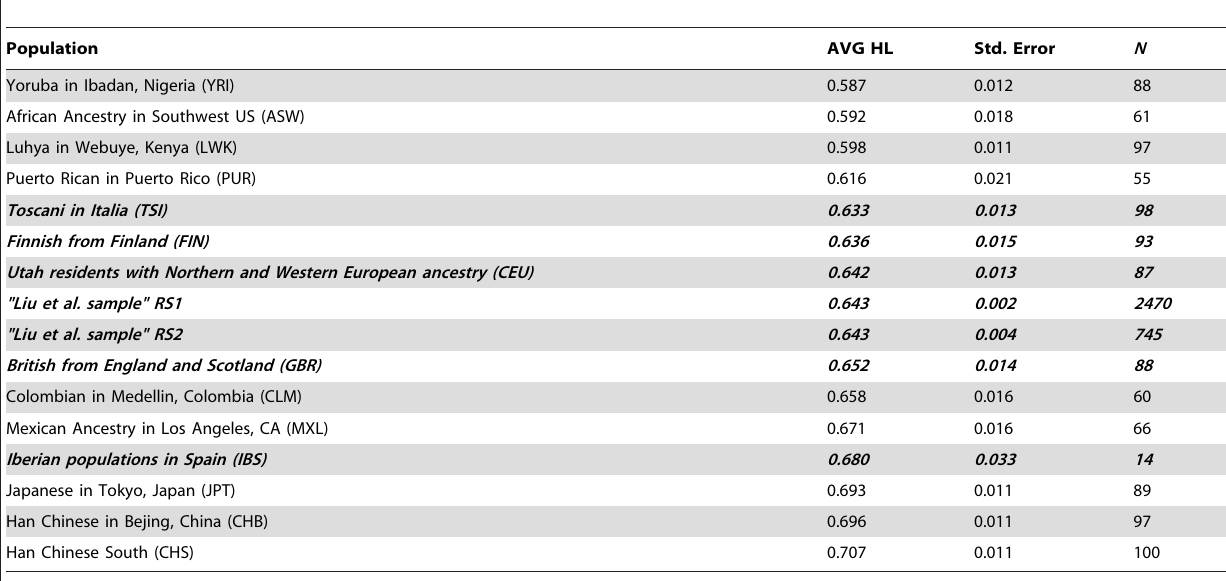
Population names, average HL, standard error of the mean, and the sample size are given. Bold italicized values indicate European populations and populations of European descent.